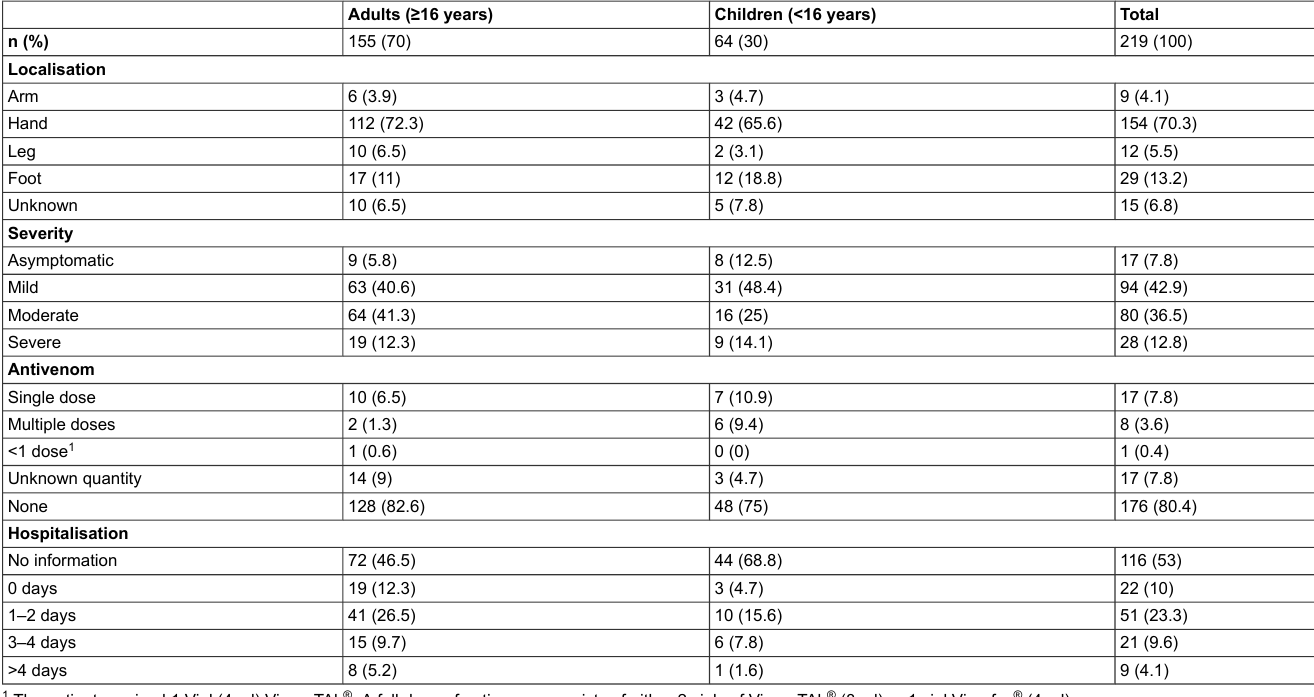
Table 2: Clinical characteristics, antivenom administration and duration of hospitalisation of patients (n =